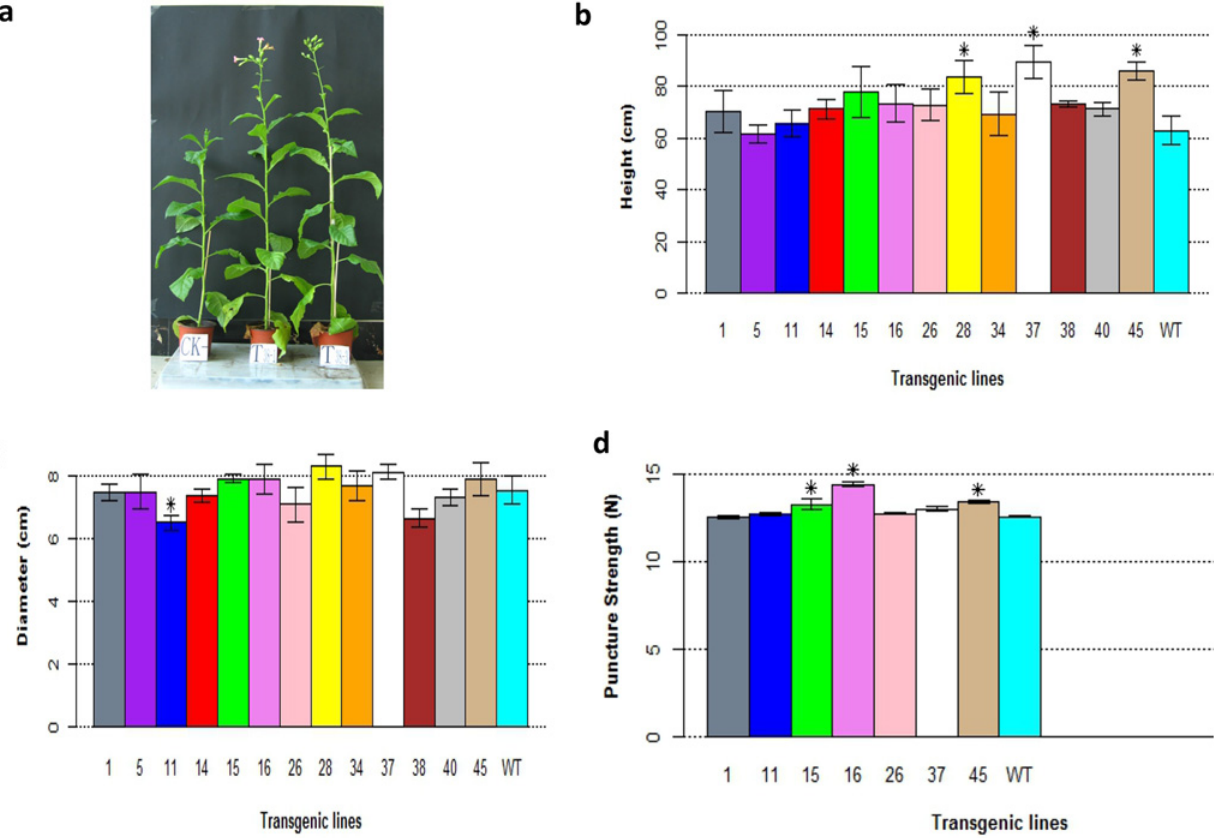
Fig 4. Phenotypic changes in PsnSusy2 transgenic lines. a. Phenotypic comparison of three-month-old tobacco transgenic line of L38 and wildtype tobacco. CK represents wildtype tobacco while T represents L38 transgenic line. b. Comparison of heights of three-month-old tobacco transgenic lines and wildtype. c. Stem diameters of three-month-old tobacco transgenic lines at 3 cm height above the root collar. d. Puncture strength of stem segments (plastichron index 5) in three-month-old transgenic lines. All measurements shown in a, b, and c were averaged from five different samples per line ± S.E. The t -test was used to examine the significance of difference between PsnSusy2 transgenic and wildtype lines, and * denotes significance at p < 0.05. The WT represents wildtype tobacco while the others lines labeled with line numbers are of different PsnSusy2 tobacco transgenic lines.